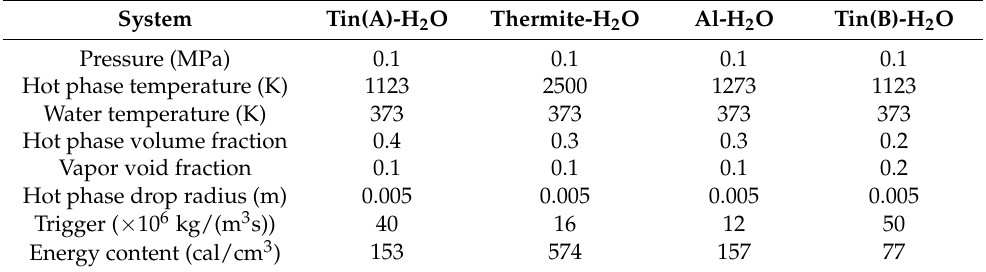
Figure 19. Calculated pressure profiles for different melts in water: ( A ) tin(A); ( B ) aluminum; ( C ) thermite; ( D ) tin(B) (adapted from Reference [95]). Table 3. Relevant initial conditions for the calculations of Reference [95] (cfr. Figure 19).